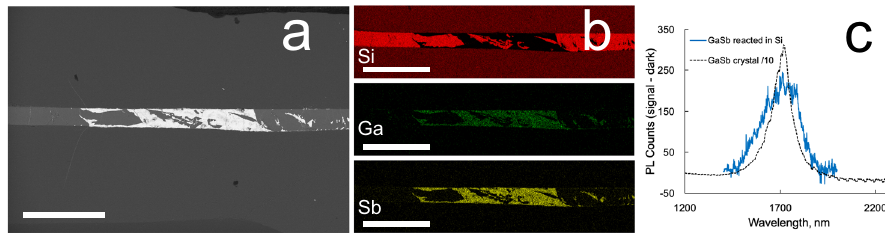
Fig. 4 Results on GaSb reactively formed inside the Si core of a fi bre at the midpoint of a 2 cm sample, using the geometry of Fig. 1d. a Backscattered SEM image of GaSb (bright areas) inside a silicon fi bre core. Ga was thermally directed from the left and Sb was brought in from the right. b EDS results showing Si (top), Ga (middle), and Sb (bottom panel), demonstrating good segregation of GaSb from Si. Scale bars 500 µ m. c GaSb photoluminescence measurements excited with 532 nm radiation for single crystal bulk material (dashed black curve; values divided by 10), and GaSb synthesised within the silicon fi bre (blue